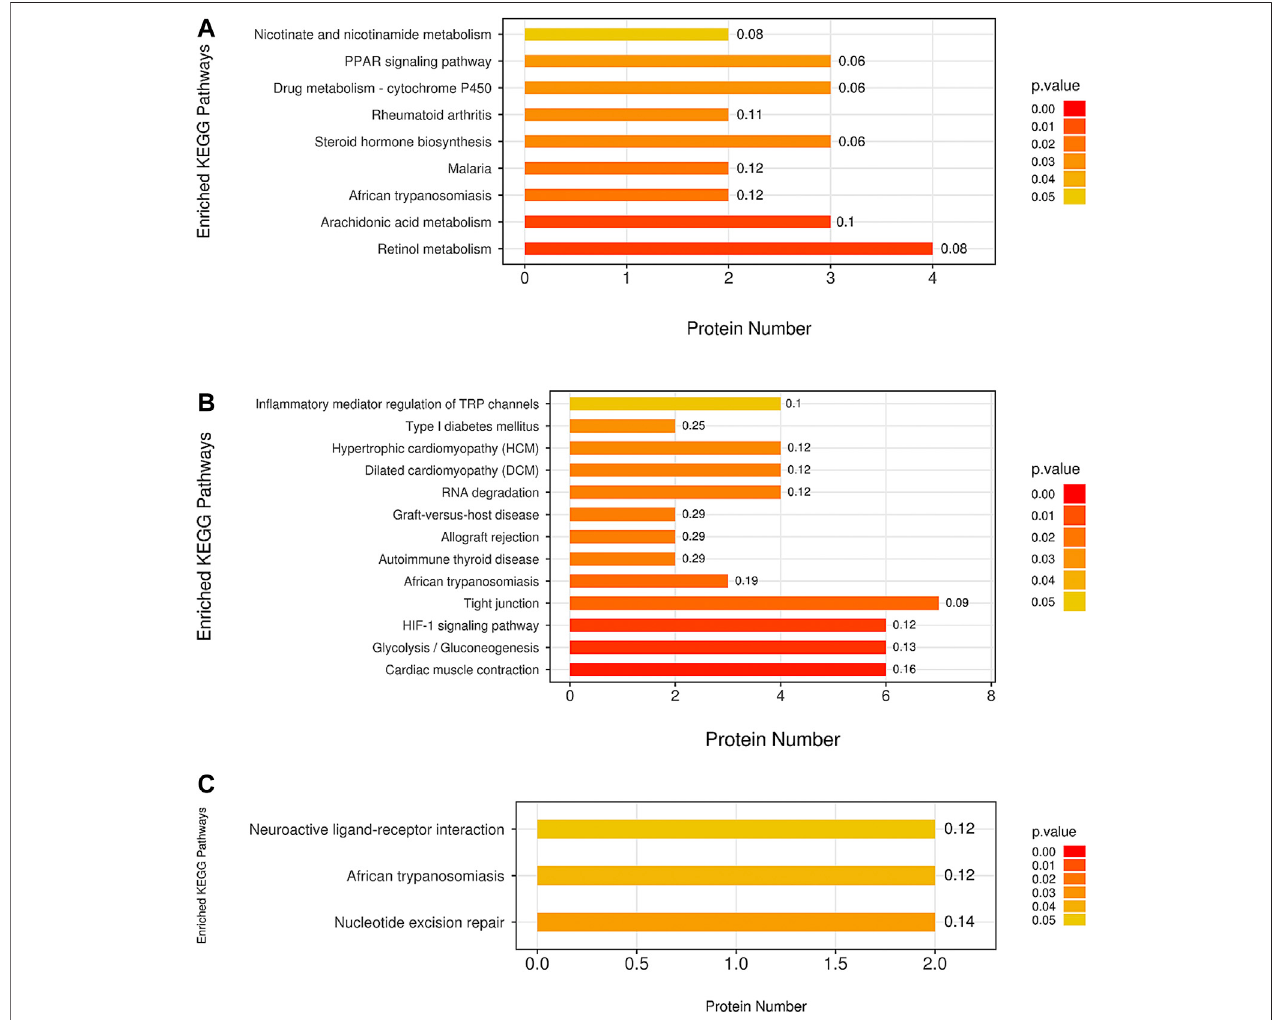
FIGURE 9 | The pathway analysis of all differentially expressed proteins was based on the KEGG (Kyoto Encyclopedia of Genes and Genomes) database. The comparison between the (A) M group and B group, between the (B) ULRA group and model group, and between the (C) YF and model groups was performed. ULRA, unprocessed lateral root of Aconitum carmichaelii ; YF,